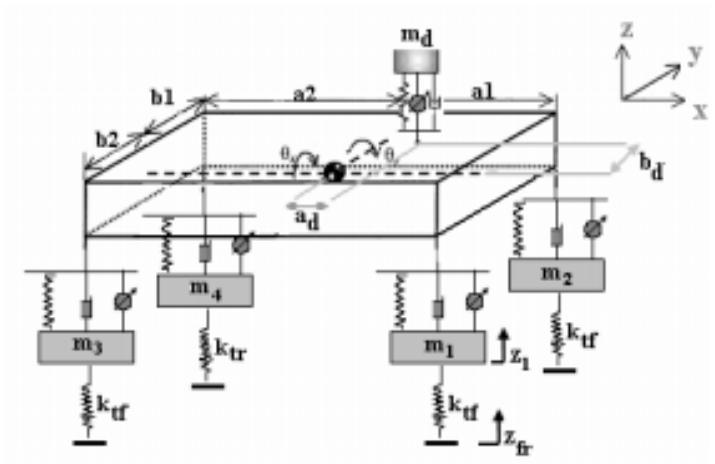
Fig. 1. Linear model of vehicle, passenger and road with 8 degrees of